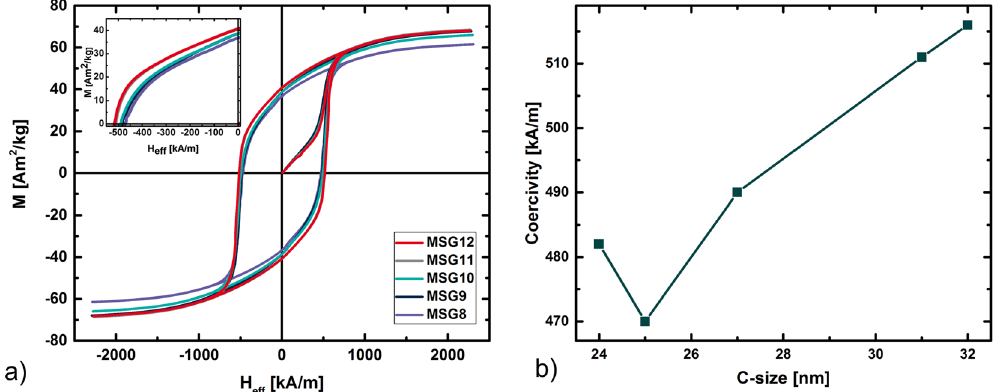
Figure 4. ( a ) Hysteresis curves (magnetisation vs effective field) of SrFe 12 O 19 synthesised by MSG, having the Fe 3 + :Sr 2 + molar ratios varied from 8 to 12. The demagnetising factor N was estimated to 0.33 as the particle shape is roughly approximated to be a sphere. ( b ) The coercivity generally increases as the crystallite C-size is increased.